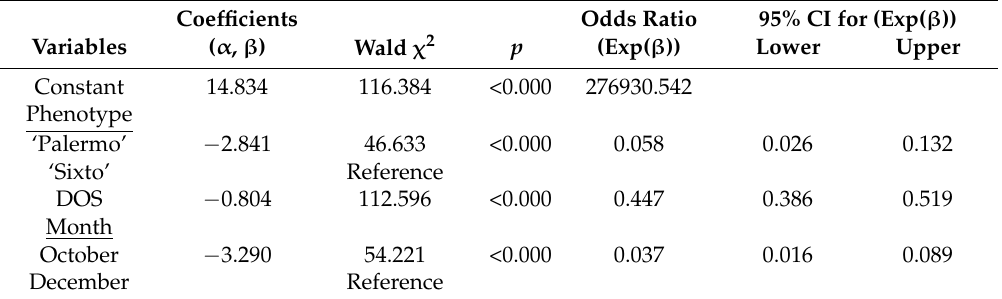
Table 7. Estimation of multiple logistic regression parameters for ‘Sixto’ and ‘Palermo’